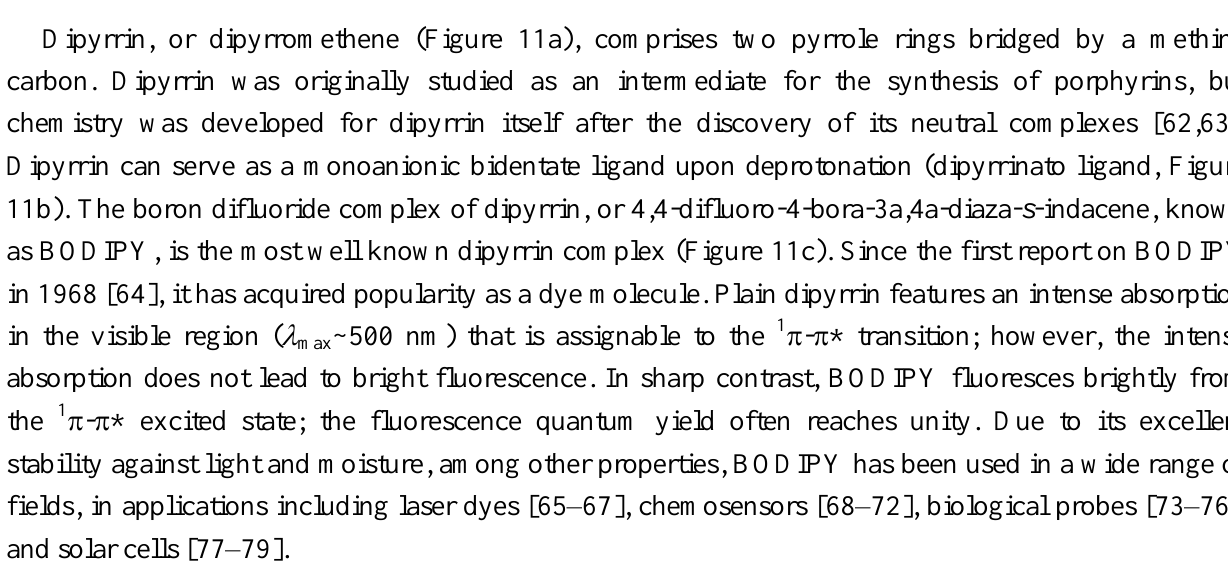
Figure 11. ( a ) Dipyrrin, ( b ) dipyrrinato ligand, ( c ) BODIPY, ( d ) bis(dipyrrinato)metal complex, and e) tris(dipyrrinato)metal